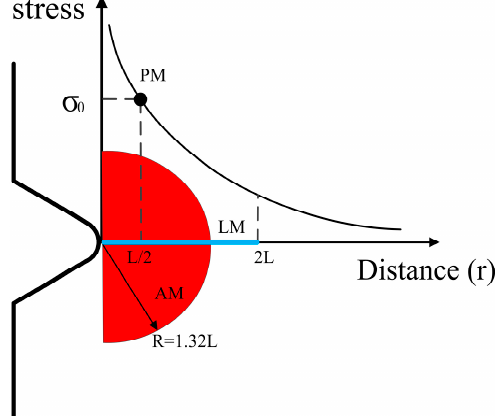
Figure 6. Schematic diagram of the critical distance method.